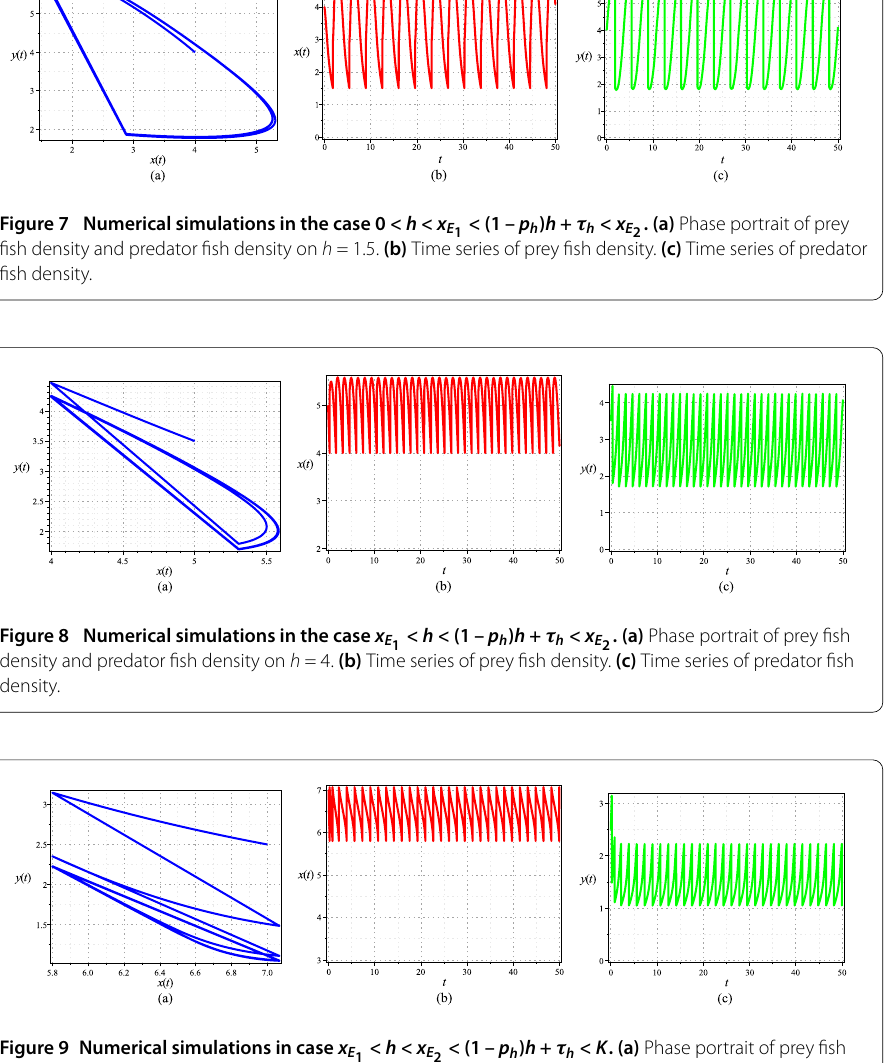
Figure 9 Numerical simulations in case x E density and predator fish density on h = 5.8. (b) Time series of prey fish density. (c) Time series of predator fish